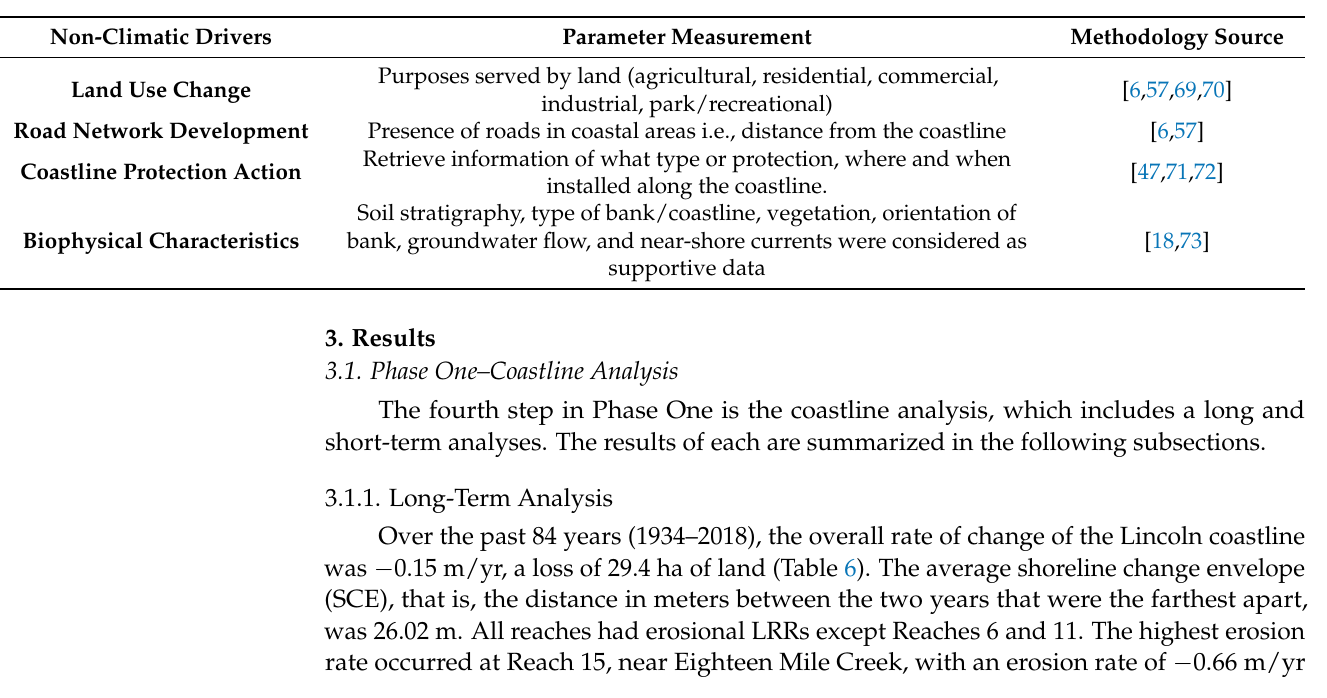
Table 5. Non-climatic factors to be investigated and selection